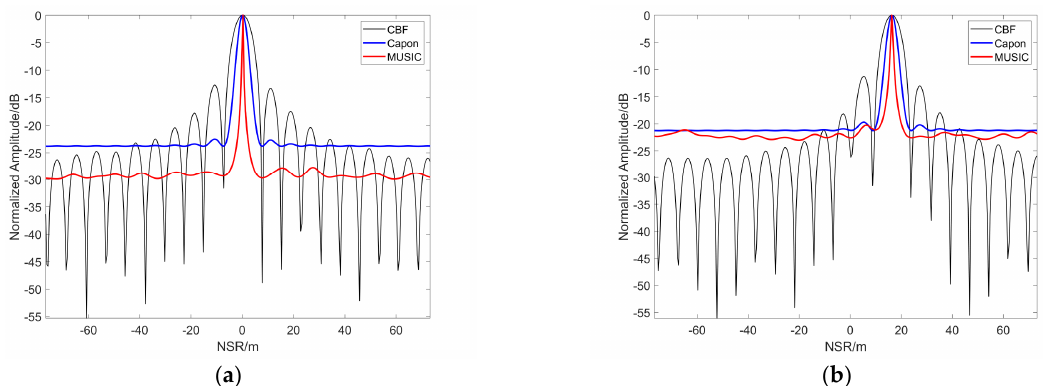
Figure 23. Moving point result ( v x = 2 m/s) with baseline number 20: ( a ) 1st point; ( b ) 55th point.